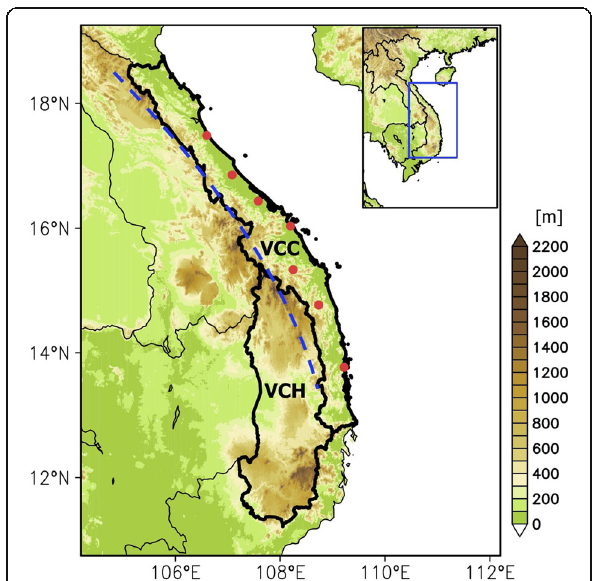
Fig. 1 Topography (shaded, m) of the VCC and the VCH (surrounded by thick-solid-black lines) and eastern part of the Indochina Peninsula. The small blue box indicates the study region. The blue broken line indicates the Truong Son Mountains. The red points show rain